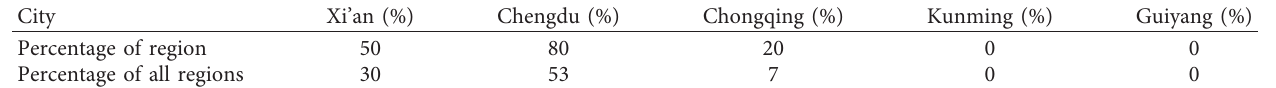
Table 5: The percentage of the optimal cross-border paths through the airport. City Xi’an (%) Chengdu (%) Chongqing (%) Kunming (%) Guiyang (%) Percentage of region 50 80 20 0 0 Percentage of all regions 30 53 7 0